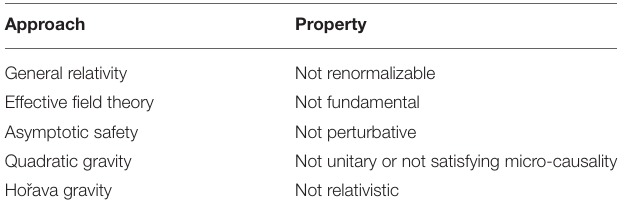
TABLE 2 | Approaches to quantum gravity characterized by properties that they do not